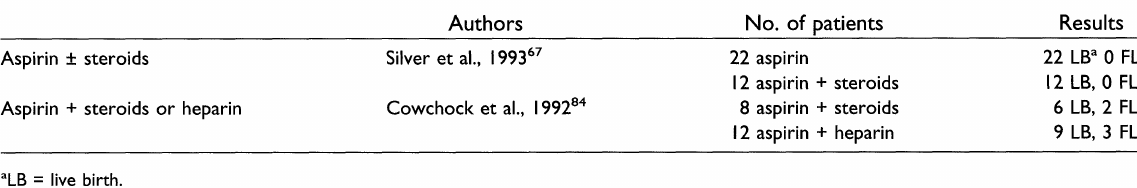
TABLE 5. Available therapeutic trials: antithrombotic + immunomodulant drugs